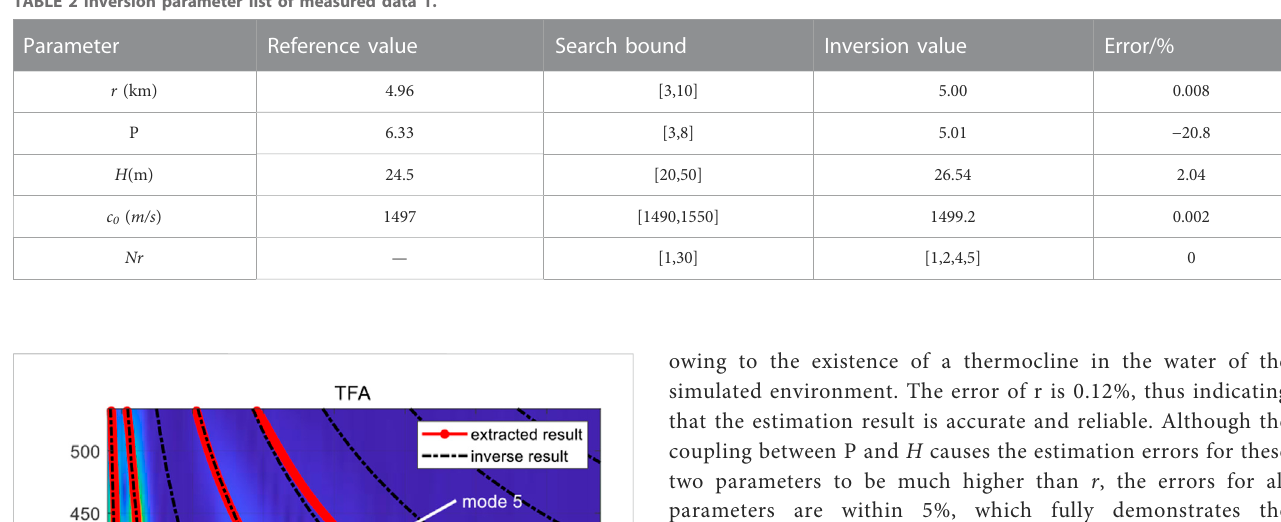
TABLE 2 Inversion parameter list of measured data 1.